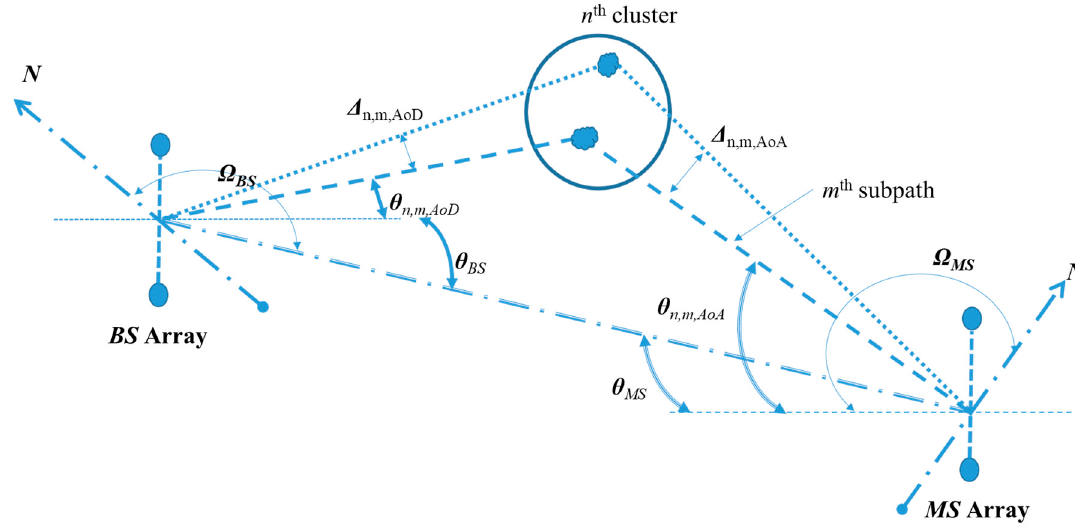
Figure 2. MIMO (multiple input multiple output) cluster channel modeling for wireless cellular